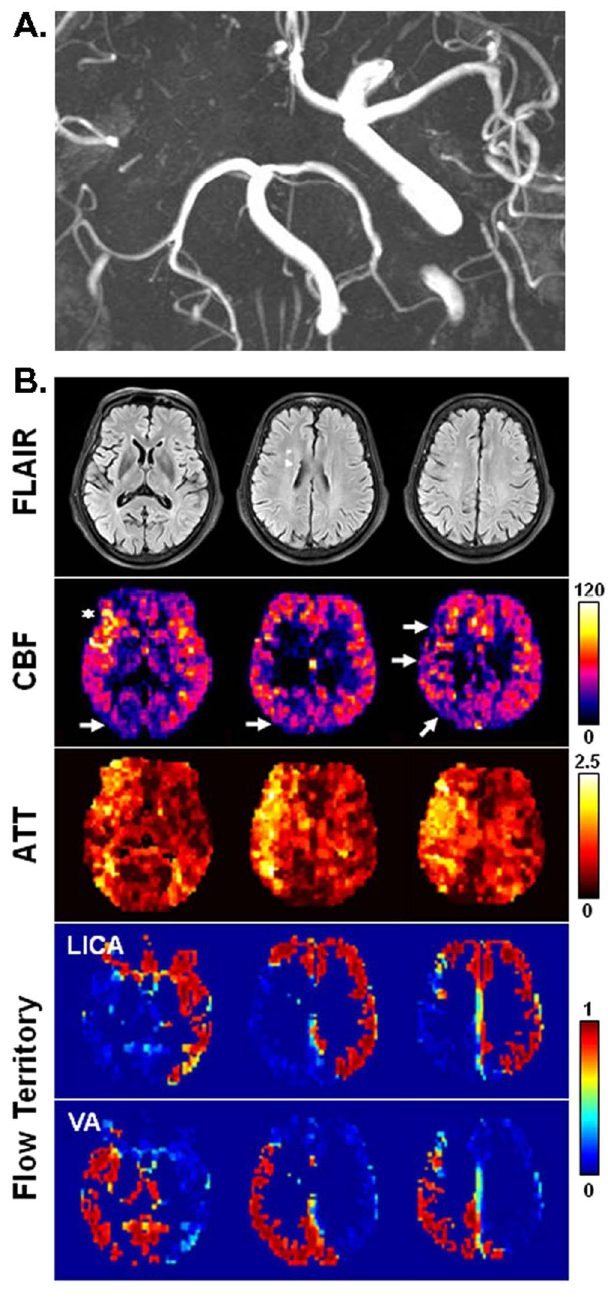
Figure 3. MR images obtained from a 60-year-old female patient with asymptomatic ICA steno-occlusive disease (occlusion in the right ICA and 30–50% stenosis in the left ICA). ( A ) Time-of-flight angiography. Projection view from below. ( B ) From top to bottom rows (3 slices are shown in radiological convention): FLAIR images, CBF maps (in units of ml-blood/100 ml-tissue/min), ATT maps (in units of sec), and flow territory maps. Flow territory maps show the membership levels generated by fuzzy clustering, which range from 0 to 1. No contribution from right ICA was extractable. In FLAIR images, there are two small foci of white matter hyperintensity in right frontal white matter which might represent chronic ischemic white matter